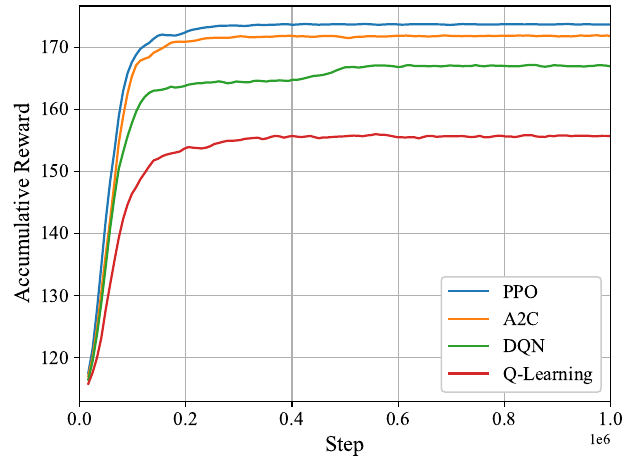
Figure 2. The results of RL